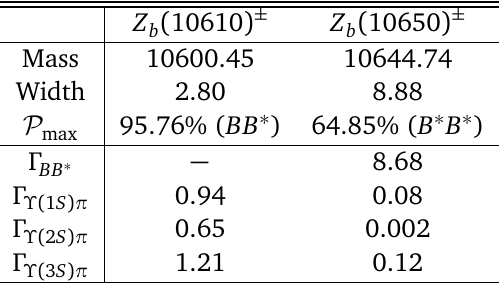
Table 2: The Z states parameters from the S -matrix pole b